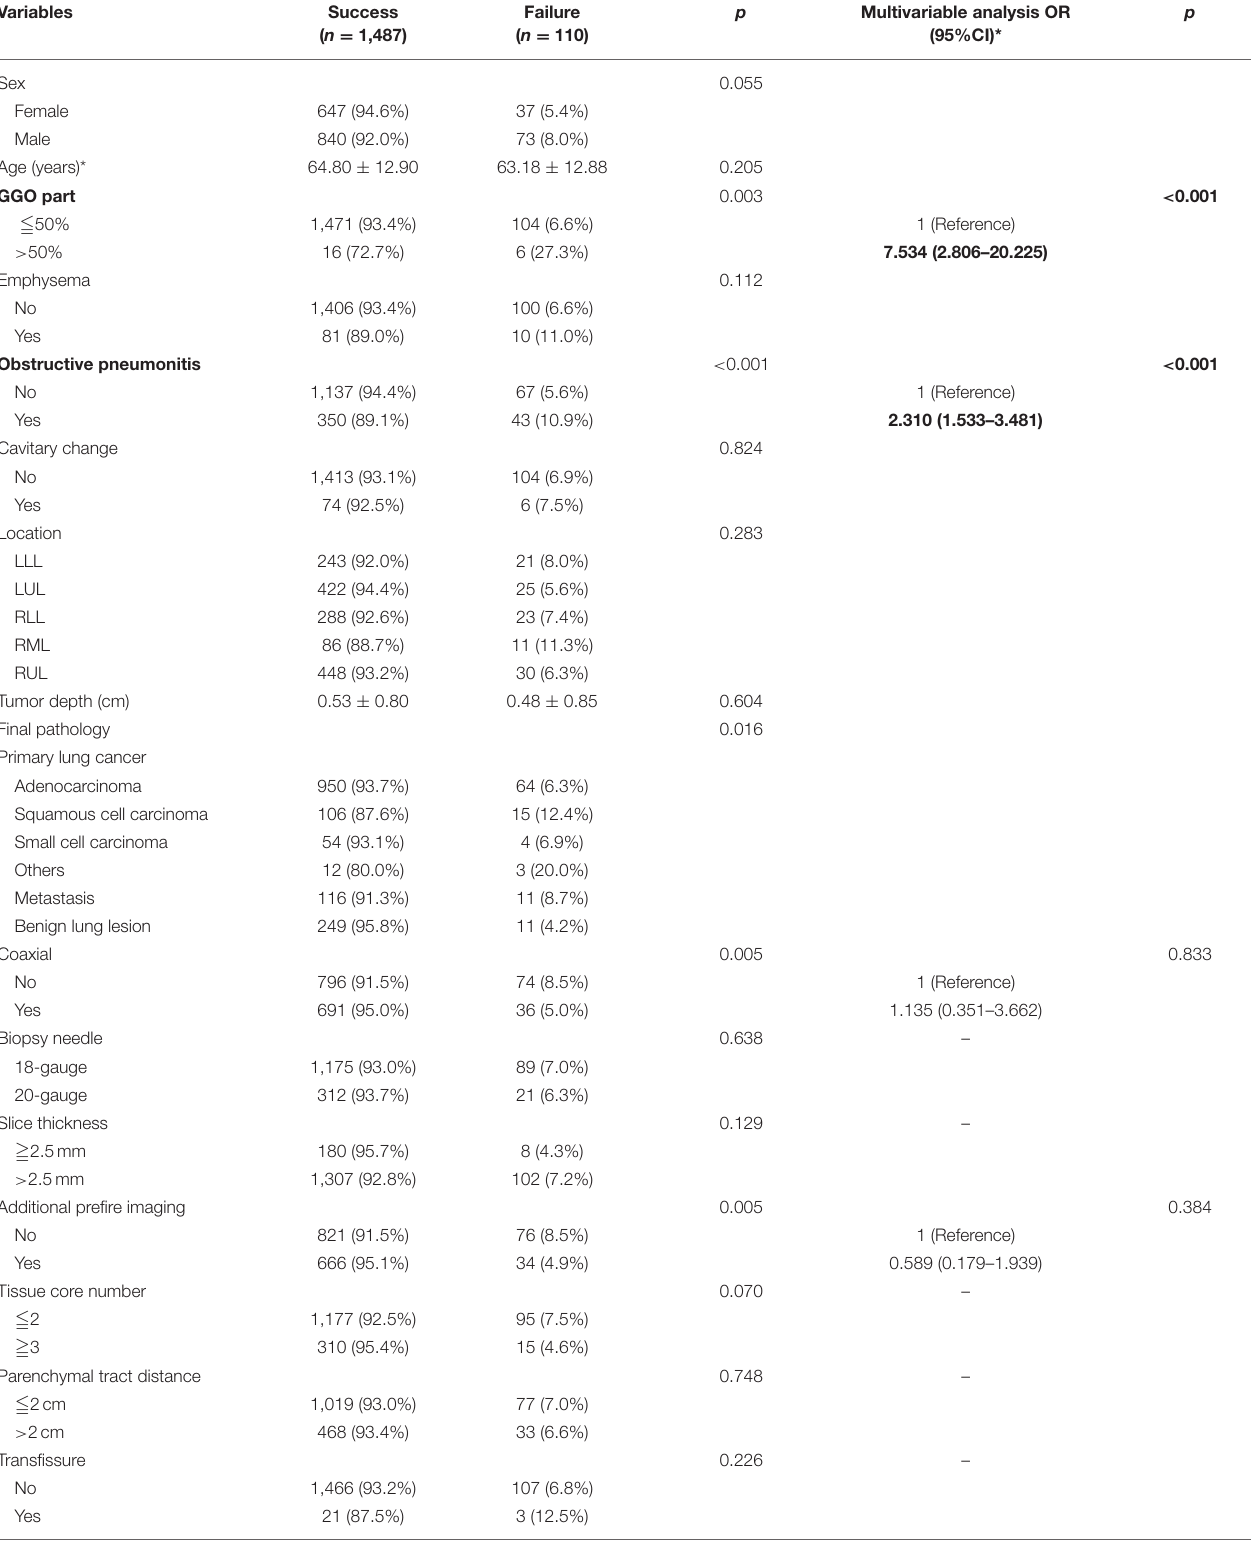
Unless otherwise indicated, data in parentheses are percentages. * Data are mean ± standard deviation. The bold values are statistically significant in multivariate analysis, p <